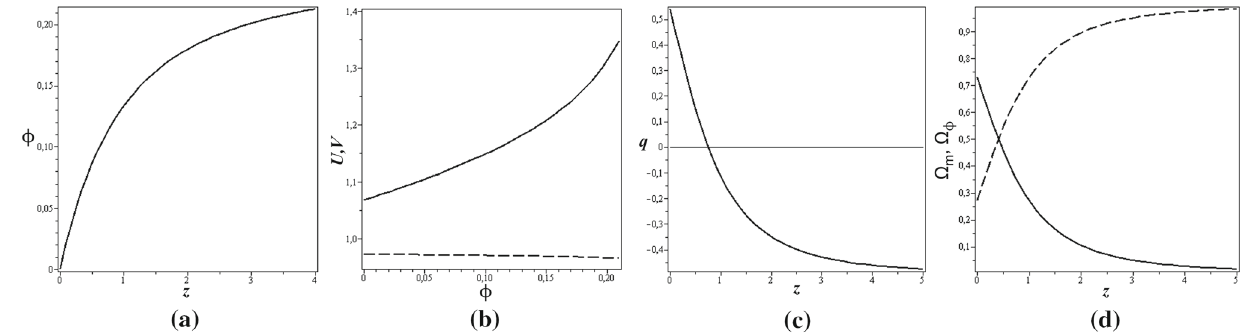
Fig. 1 a Plot of φ as a function of z . b Plot of V (solid curve) and U (dashed curve) as a function of φ . c Plot of q as a function of z . d Plot of Ω φ (solid curve) and Ω m (dashed curve) as a function of z . This is for cosmological constant, with φ 0 = 0, H 0 = 1, ω 0 = − 0 . 95 and Ω m 0 = 0 . 27